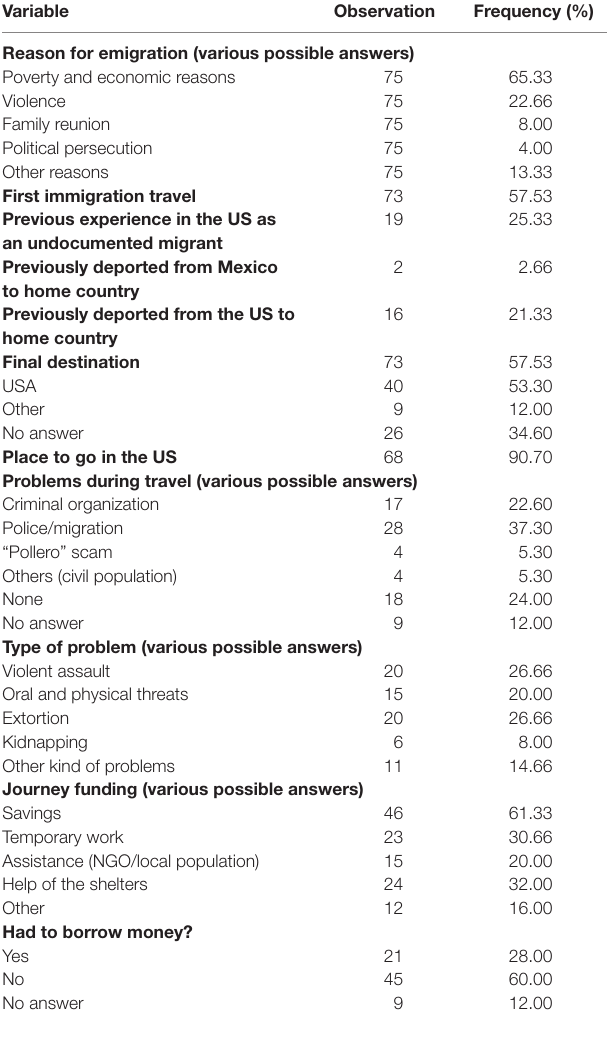
TaBle 5 | emigration